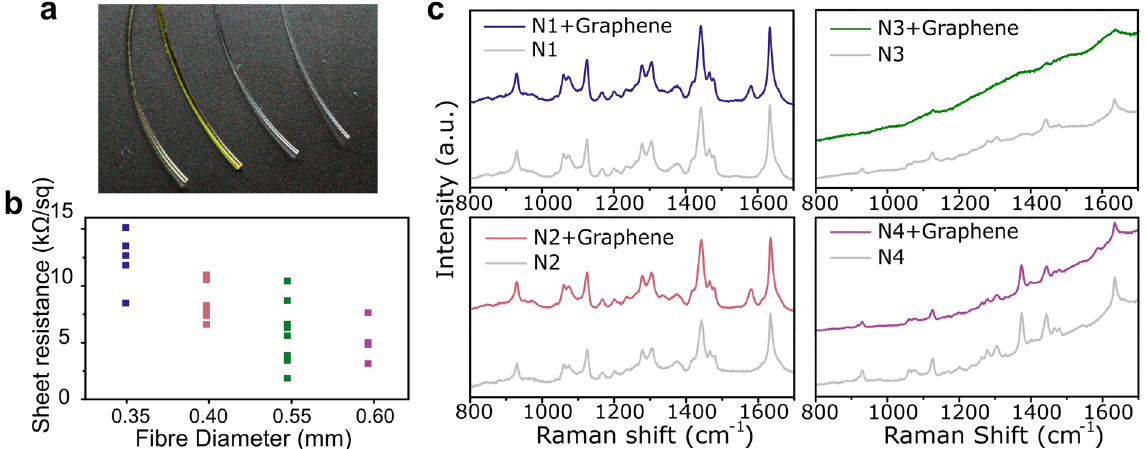
Figure 4. ( a ) Photo of the 4 samples, left to right: N1, N2, N4 and N4. ( b ) Sheet resistance for graphene-coated nylon fibres N1 (blue); N2 (pink); N3 (green) and N4 (purple). ( c ) Raman spectra of bare fibres (grey) and corresponding graphene-coated fibres (same colour scheme as in ( a